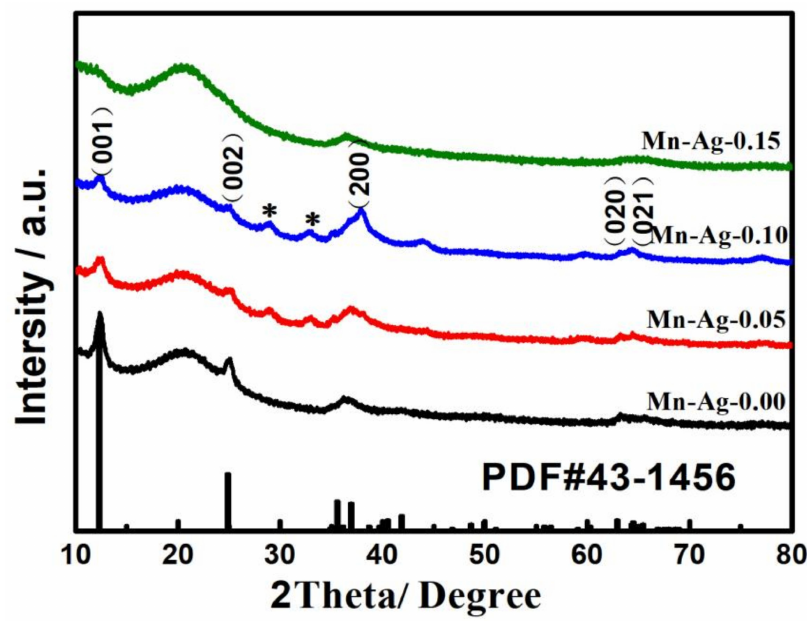
Figure 2. XRD patterns of Mn-Ag-0.00, Mn-Ag-0.05, Mn-Ag-0.10, and Mn-Ag-0.15 samples.